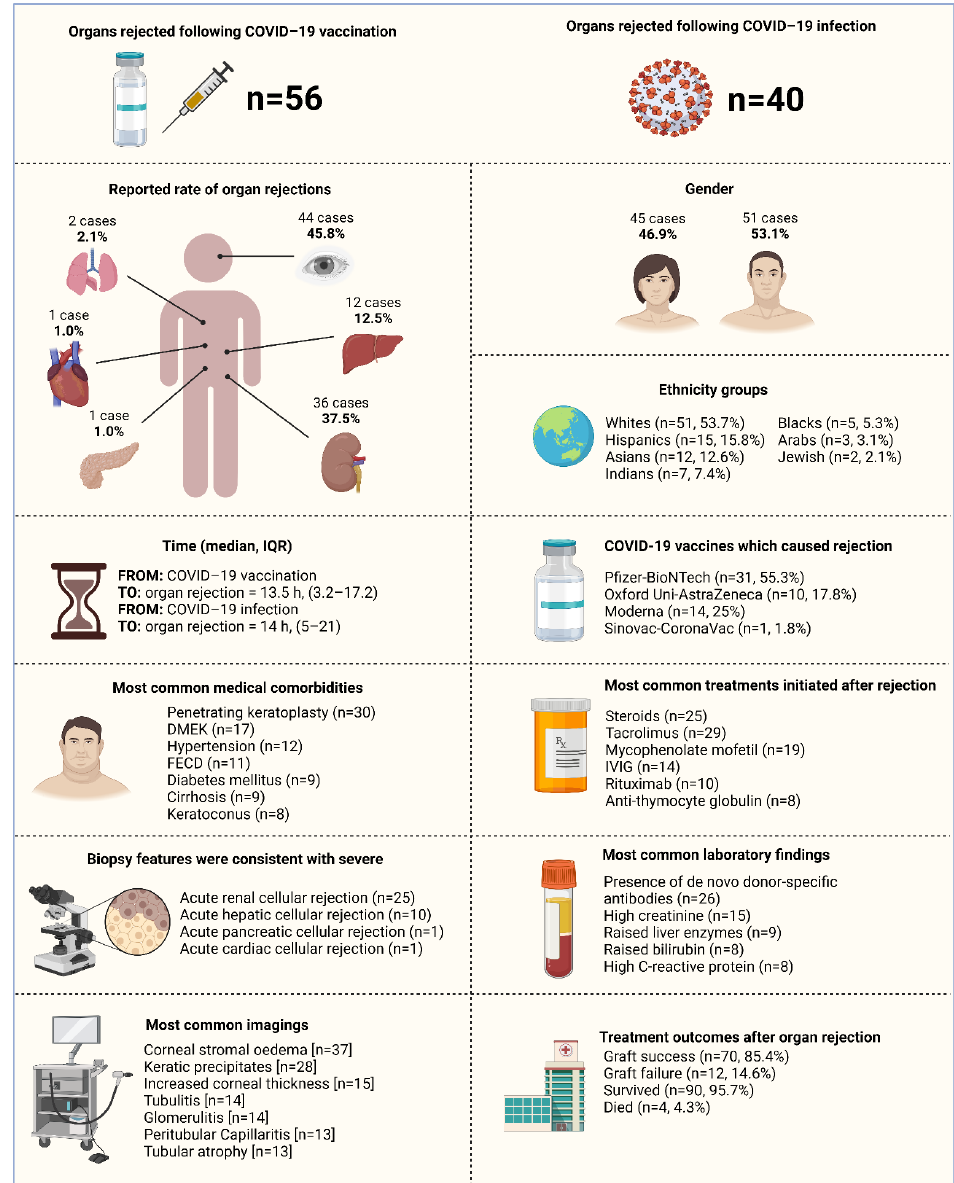
Figure 3. Summary of the characteristics of the included studies with evidence on organ rejection following COVID-19 vaccination and post-COVID-19 infection ( n = 52 studies), 2020–2022. Abbrevia- tions: COVID-19, coronavirus disease 2019; IVIG, intravenous immunoglobulin; DMEK, Descemet’s membrane endothelial keratoplasty; FECD, Fuchs endothelial corneal